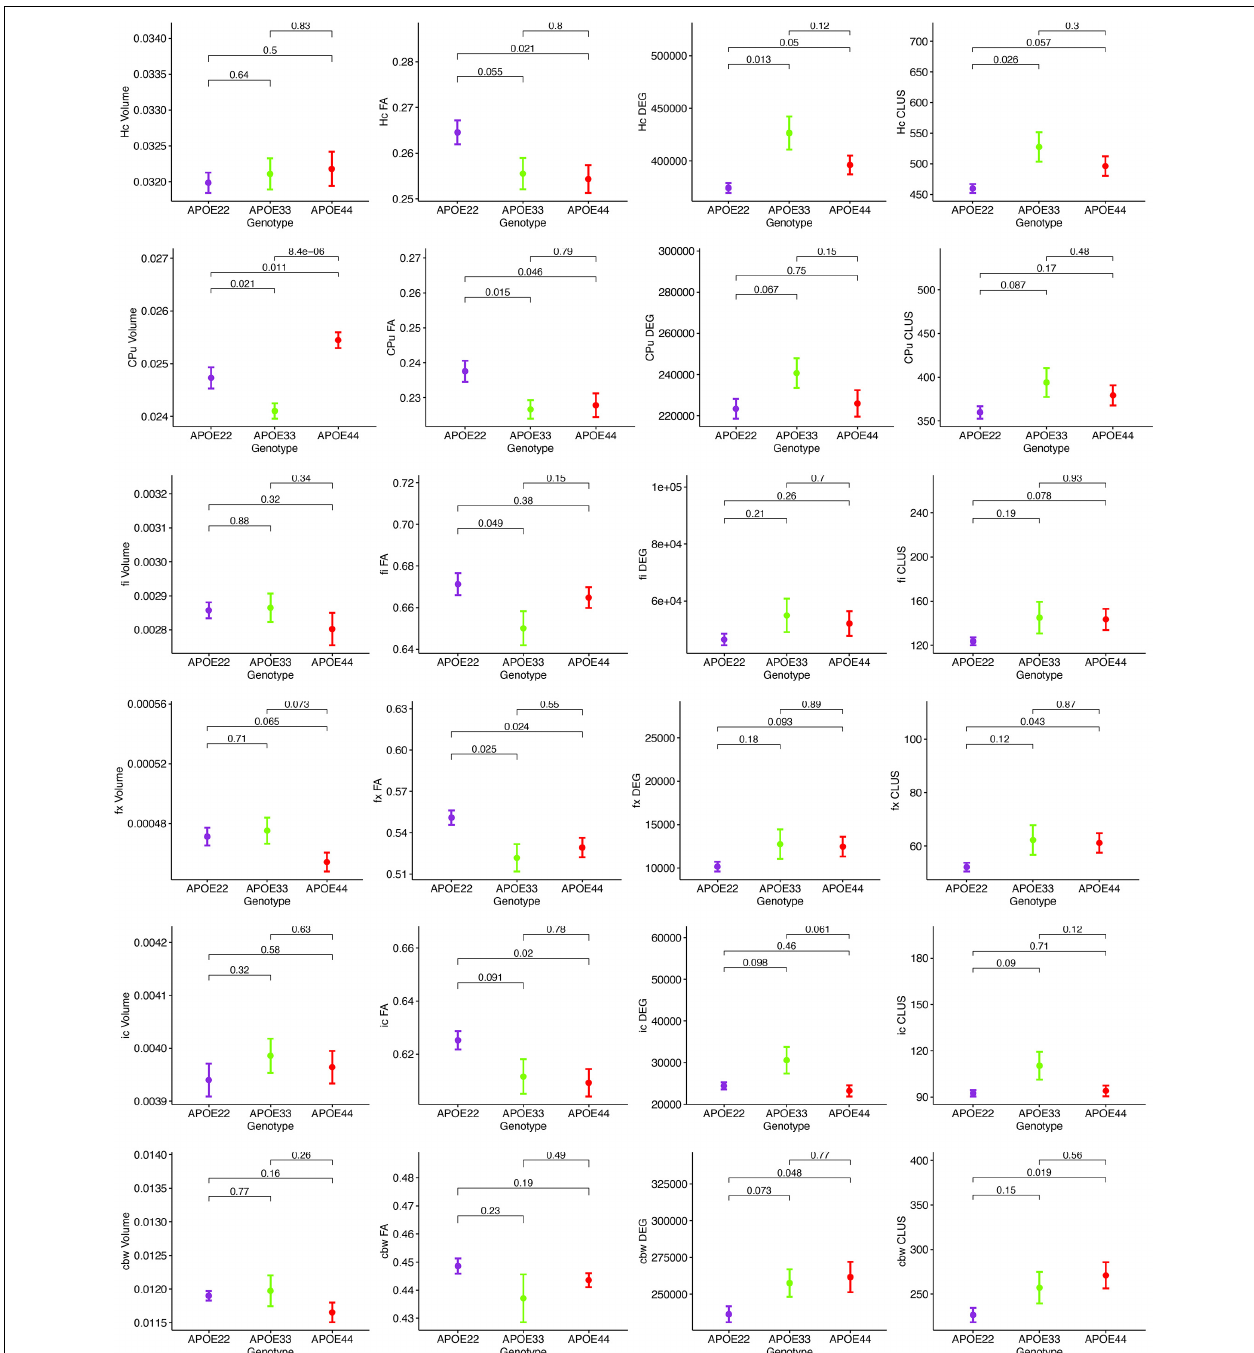
FIGURE 6 | Imaging and network markers for volume, FA, degree of connectivity and clustering coefficient showed APOE genotype differences. Graphs show mean ± standard error.